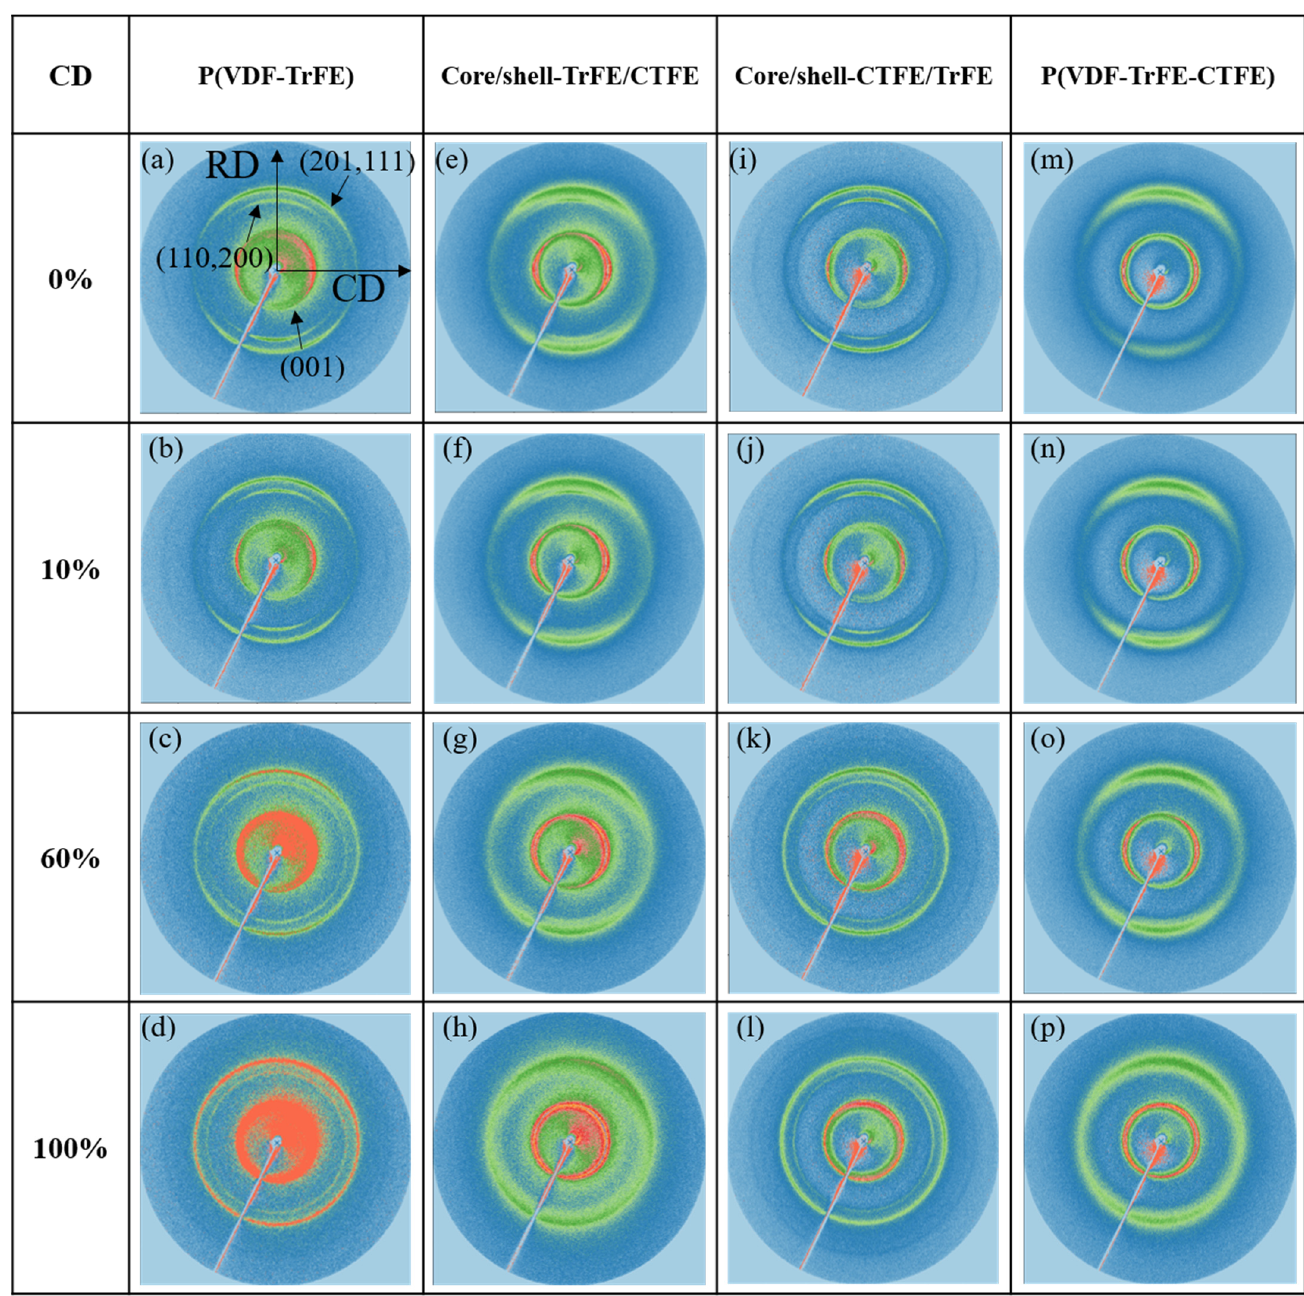
Figure 7. 2D WAXS patterns in the single and coaxial electrospun membranes at the designated strains in CD. ( a – d ) are patterns of single P(VDF-TrFE) membrane. ( e – h ) are patterns of core/shell-TrFE/CTFE membrane. ( i – l ) are patterns of core/shell-CTFE/TrFE membrane. ( m – p ) are patterns of single P(VDF-TrFE-CTFE) membrane.